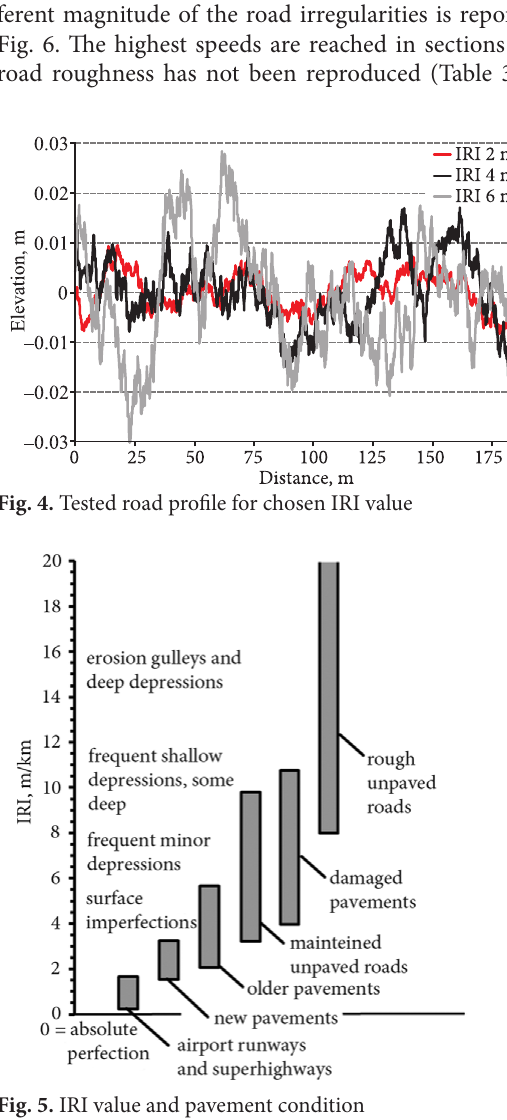
Fig. 5. IRI value and pavement condition